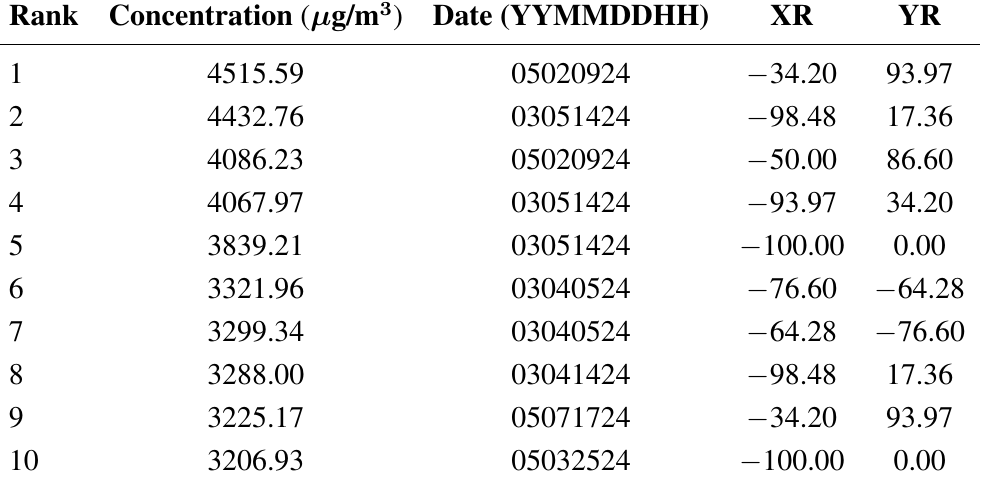
Table 4. Ten highest concentration on 24 h averaging time. XR and YR are the receptor’s